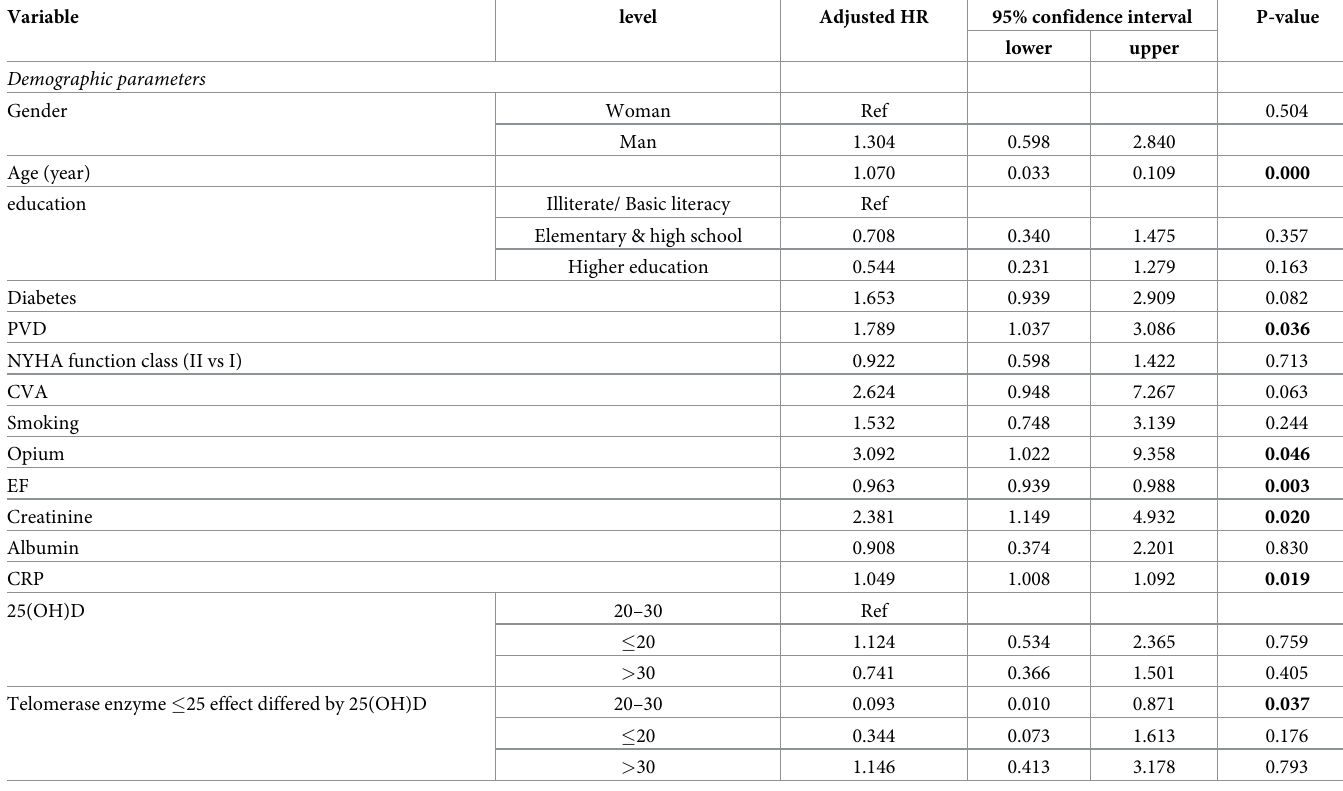
Table 3. Adjusted multivariate model for 10-year all-cause mortality using Cox